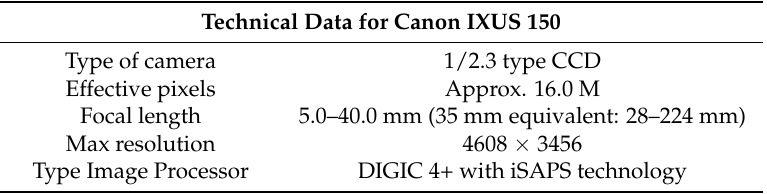
Table 1. The Canon IXUS 150 characteristics.